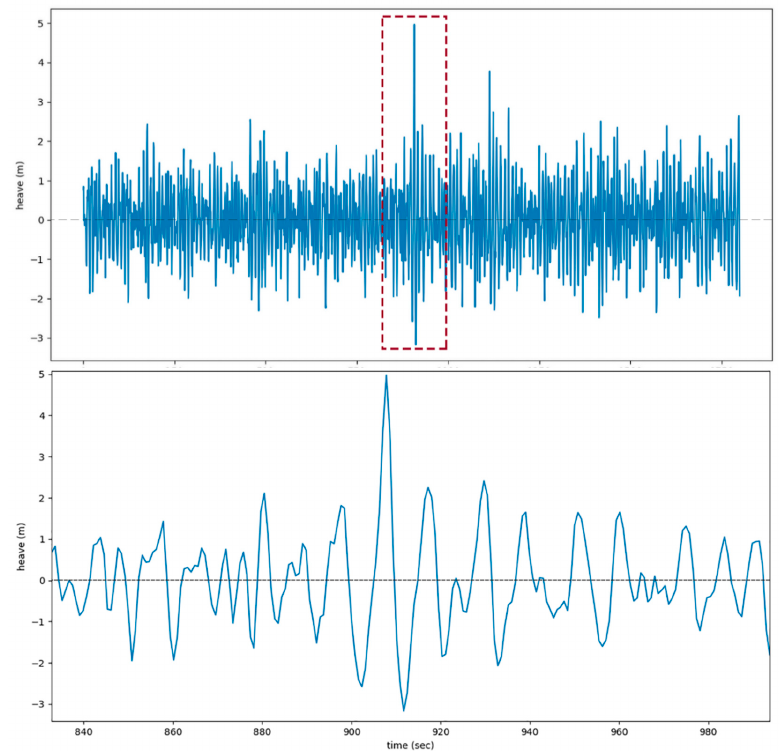
Figure 3. The surface elevation (heave) data of a rogue wave event that was identified by the buoy on 23 January 2016 at ~10:33 UTC. The raw heave data depict the individual wave height and the maximum wave height as being almost 8 m, which can clearly be seen as being at least two times higher than the average wave height in that 30-min (1800 s) sample. As the location of the buoy is mainly protected by land to the east, we expected that the largest waves would come from the west (from 180° to 360°). Indeed, the highest waves came from a narrow directional spread of 245° to 295° (Figure 4).